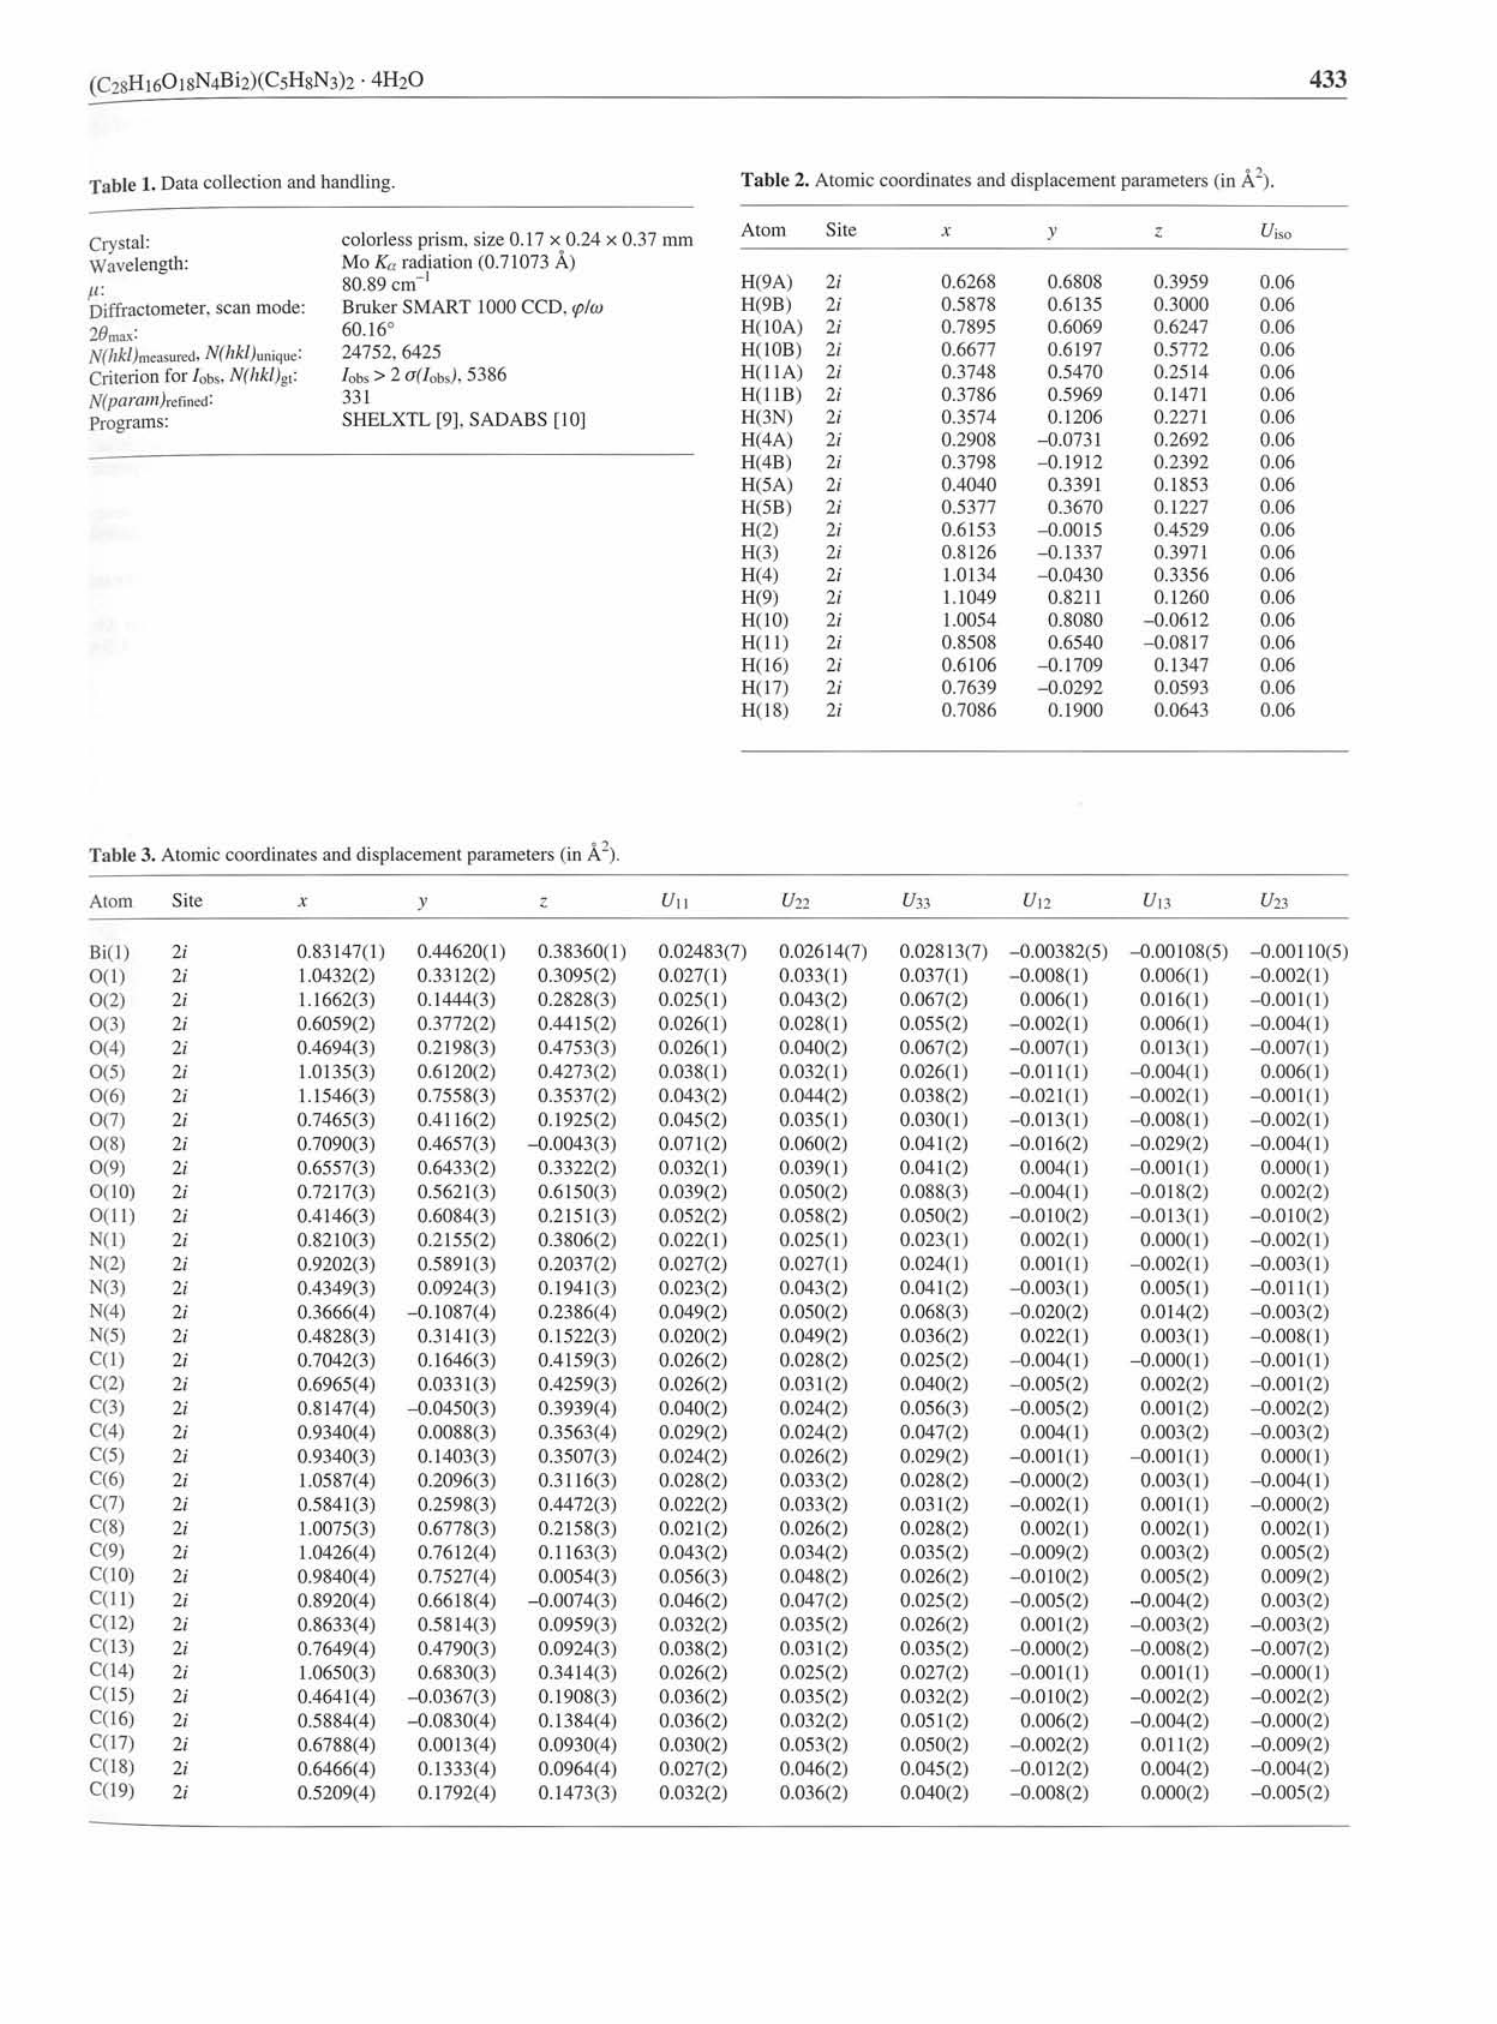
Table 1. Data collection and handling. Table 2. Atomic coordinates and displacement parameters (in Á").